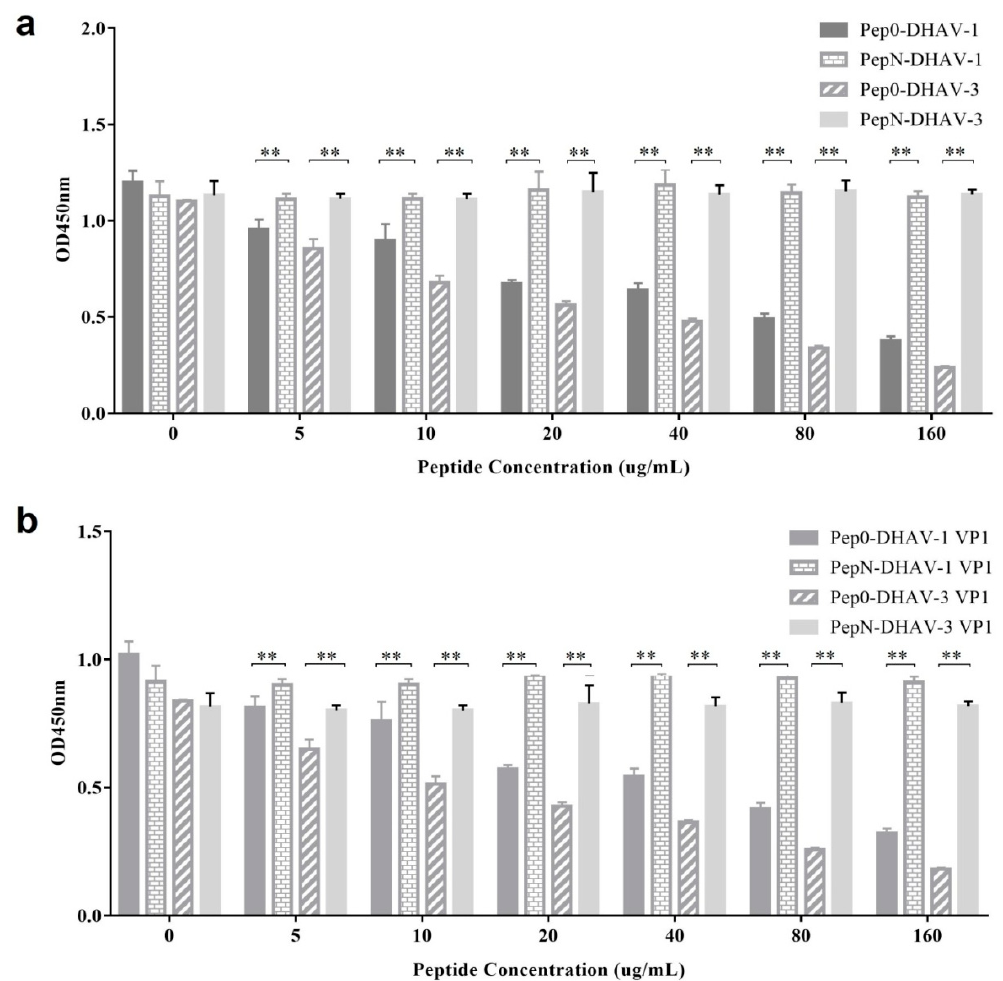
Figure 4. Synthetic peptide Pep0 competitive inhibition of mAb 4E6 to binding DHAVs: ( a ) a competitive ELISA was performed using the antigen peptide as the competitor for the DHAV-1 and DHAV-3; ( b ) a competitive ELISA was performed using the antigen peptide as the competitor for the 1VP1-Sf9 expressed lysate and 3VP1-Sf9 expressed lysate. Values represent three independent experiments with triplicates for each experiment. **, p < 0.01.